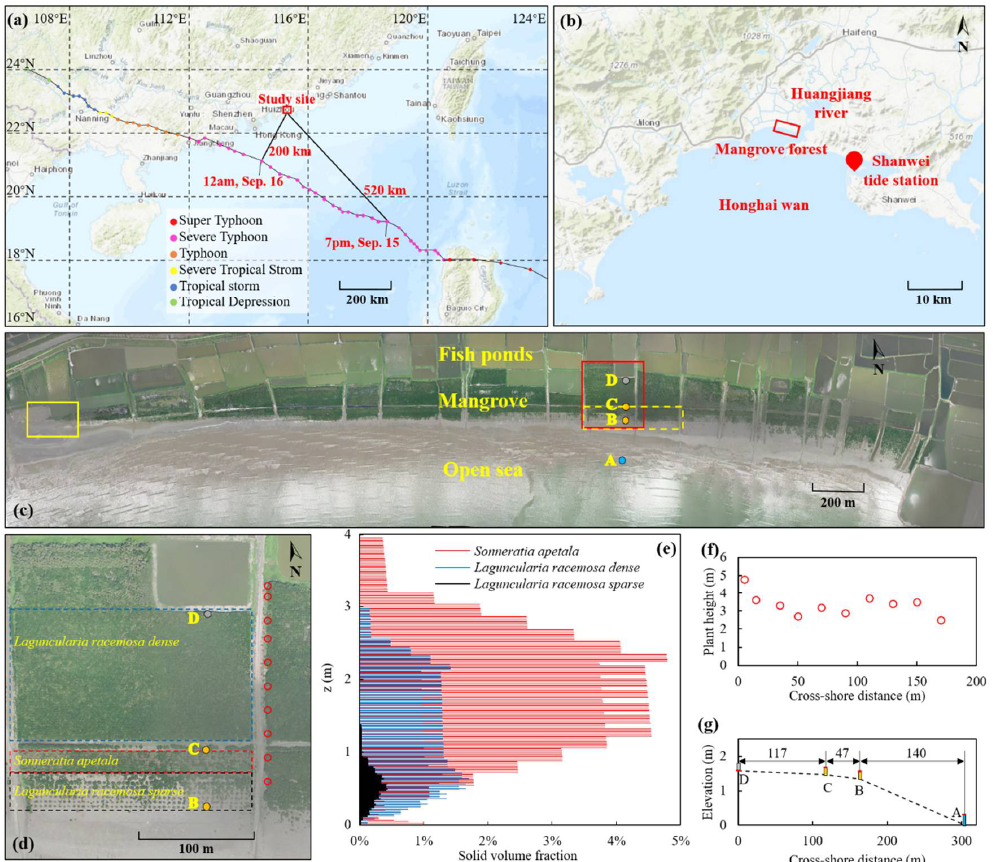
Figure 1. The track of Super Typhoon Mangkhut relative to the study site ( a ), which located in an inner lagoon in Honghai wan ( b ). The red box in ( b ) indicates the full mangrove forest and a clear view was shown in ( c ). The filled circles marked the locations of the pressure gages installed at stations A to D. The red box, solid yellow box, and the dashed yellow box correspond to the mangrove region shown in ( d ), Figure 7 and Figure 8, respectively. ( d ) The cross-shore transect contain three regions from the shore side to the offshore side, i.e., the dense Laguncularia racemosa (blue-line bounded region), the dense Sonneratia apetala (red-line bounded region), and the sparse Laguncularia racemosa (black-line bounded region), which correspond to the vertical variation of solid volume fraction shown with blue, red, and black bars in ( e ), respectively. The red circles in ( d ) indicate the locations of cross-shore plant height measurements shown in ( f ). ( g ) The elevation of the stations relative to the mud surface at station A, the horizontal arrows indicate the distances between two stations and the dashed line indicate the surface of the tidal